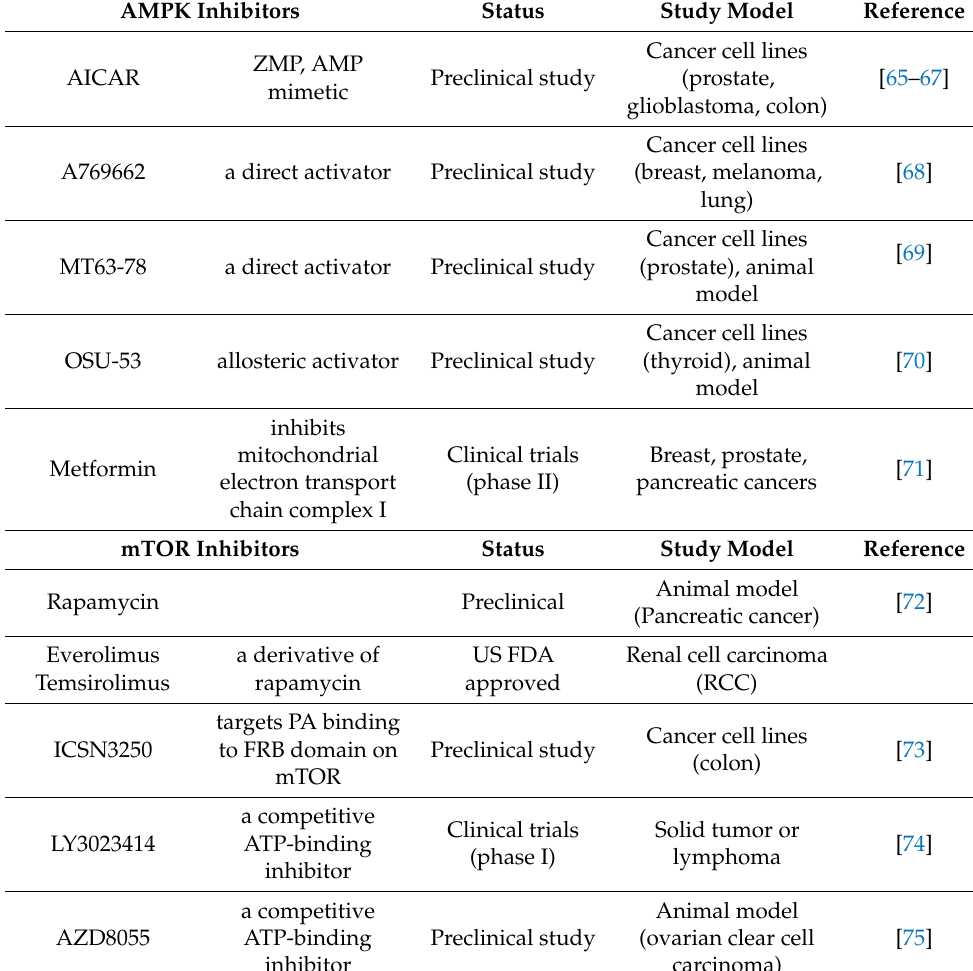
Table 1. Trials using AMPK activators and mTOR inhibitors as anti-cancer